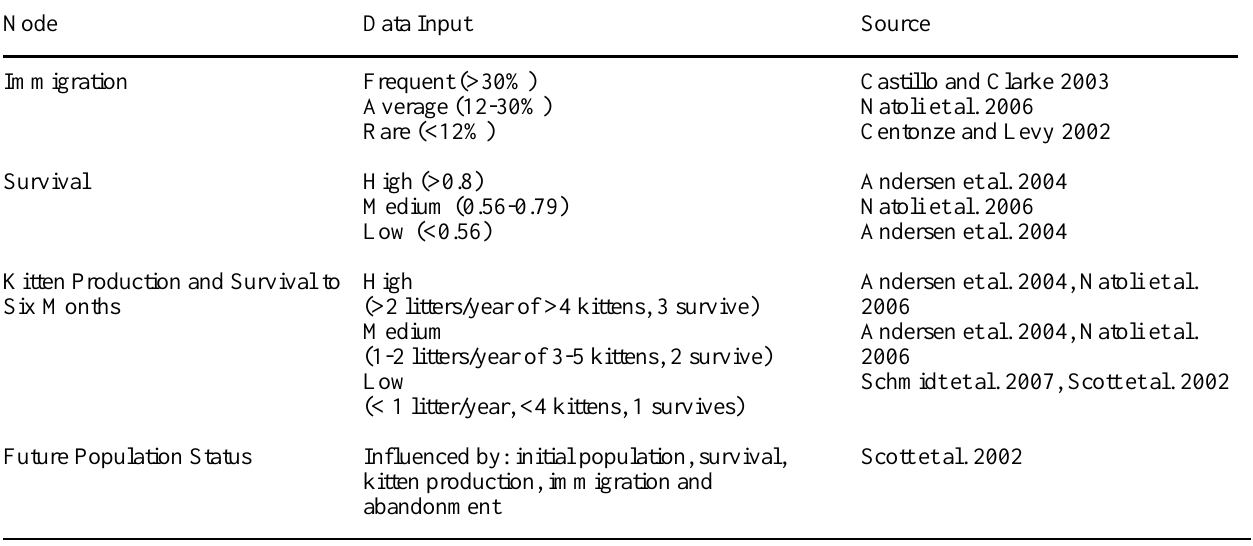
Table 2 . Information used to parameterize population